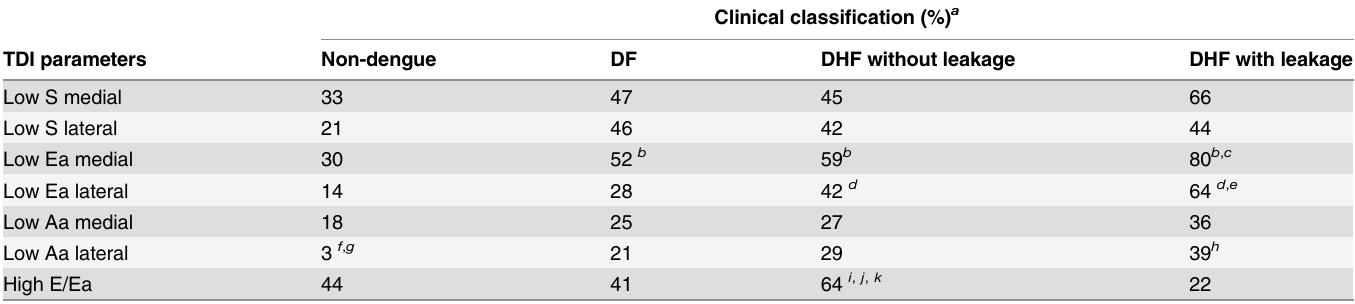
Table 4. Frequencies of cases with abnormal TDI findings on the first day of the